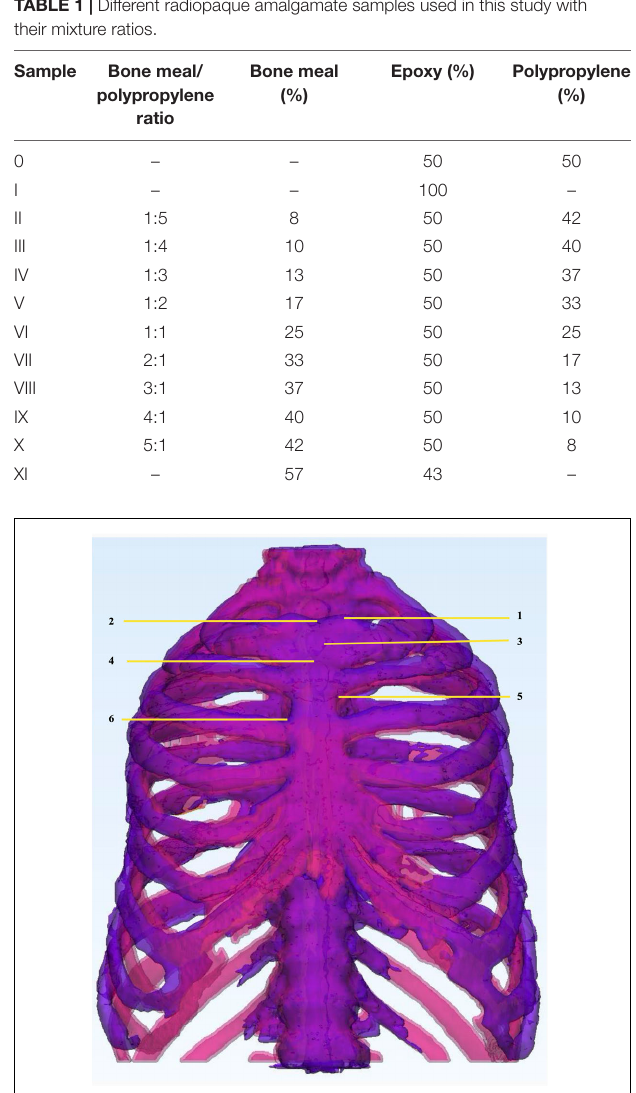
FIGURE 3 | Physical dimensional comparison of 3D printed thorax phantom. Registration of thorax phantom STL (purple) on patient STL (pink) in 3-Matic 13.0 software using the following anatomic landmarks: (1) Clavicular notch, (2) Jugular notch, (3) Manubrium, (4) Sternal angle, (5) Superior articular angle, (6) Inferior articular